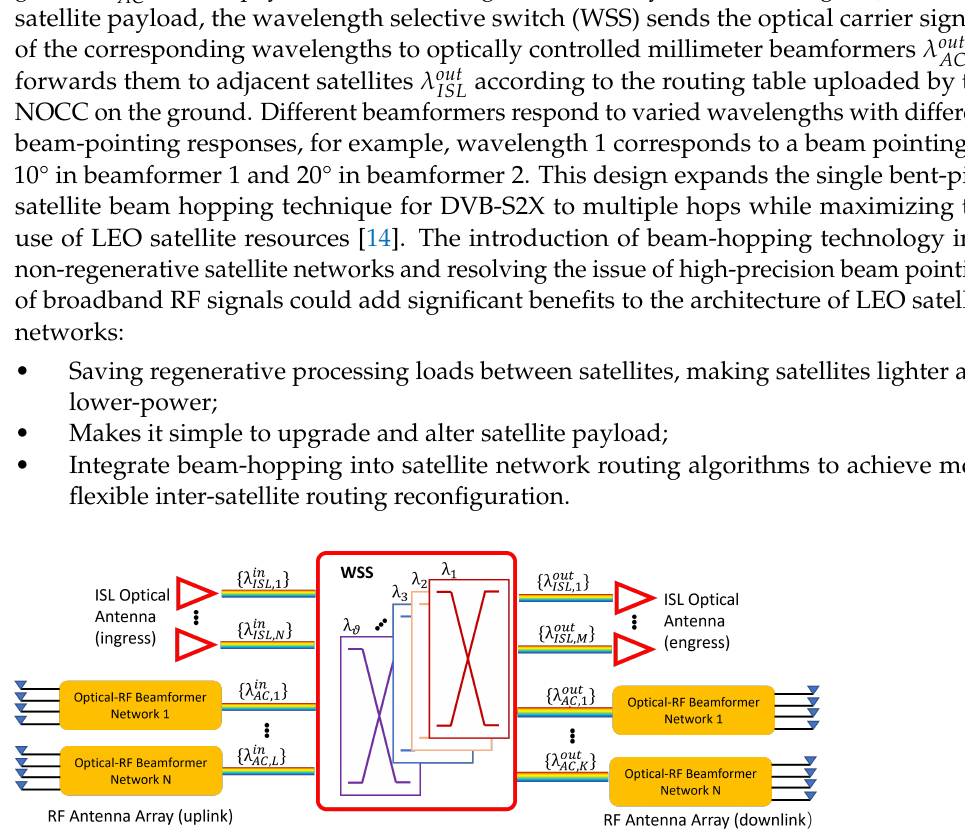
Figure 3. Payload